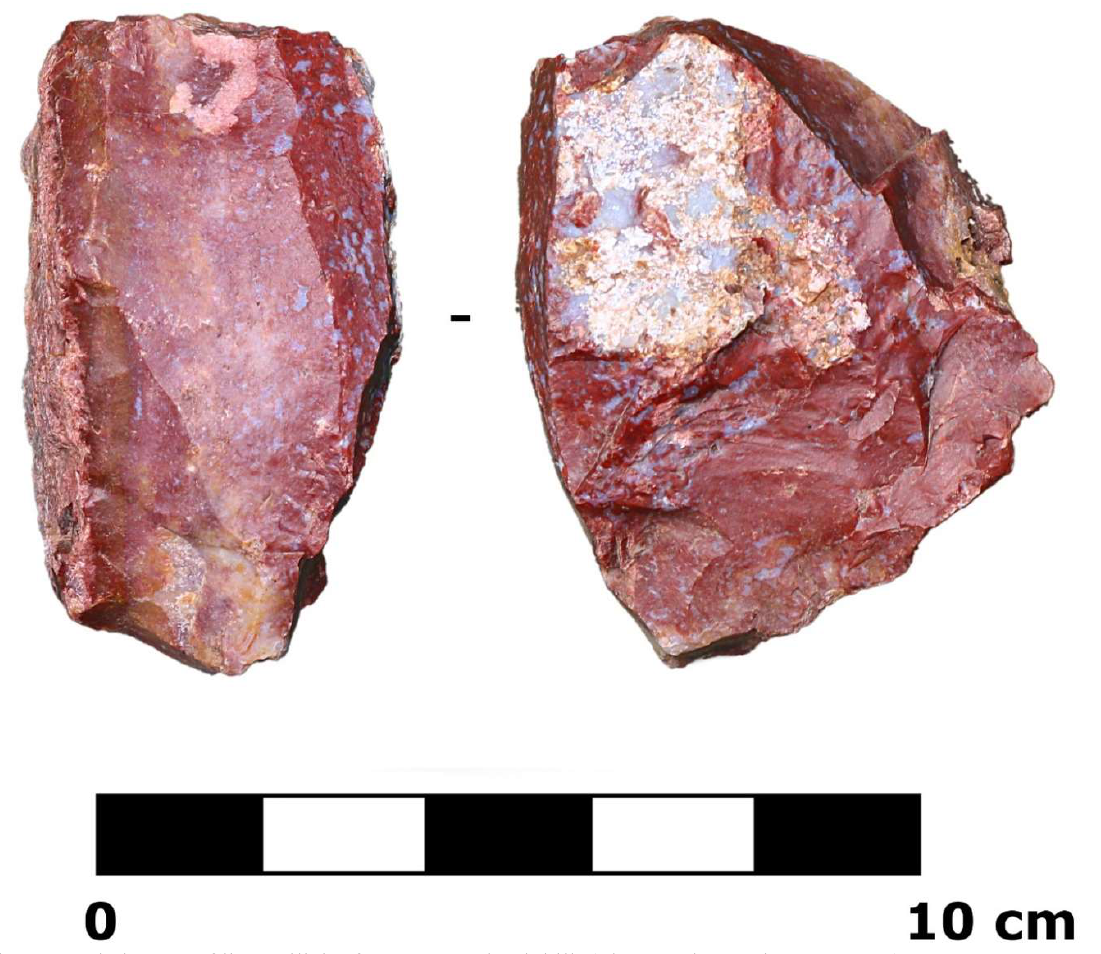
Figure 6. Blade core of limnosilicite from Bánya-domb hill. (Photo and CAD by N. Faragó) Figure 6. Nucléus laminaire en limnosilicite provenant de Bánya-domb. (Cliché et DAO N.